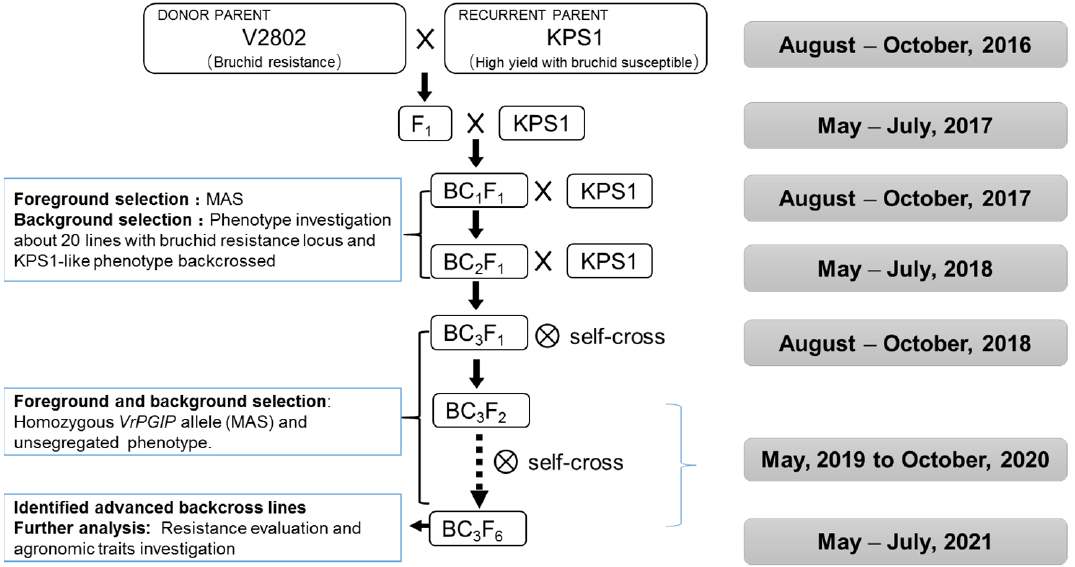
Figure 1. Introgression of the VrPGIP2 gene, conferring bruchid resistance, from V2802 into KPS1 using the MABC breeding strategy.